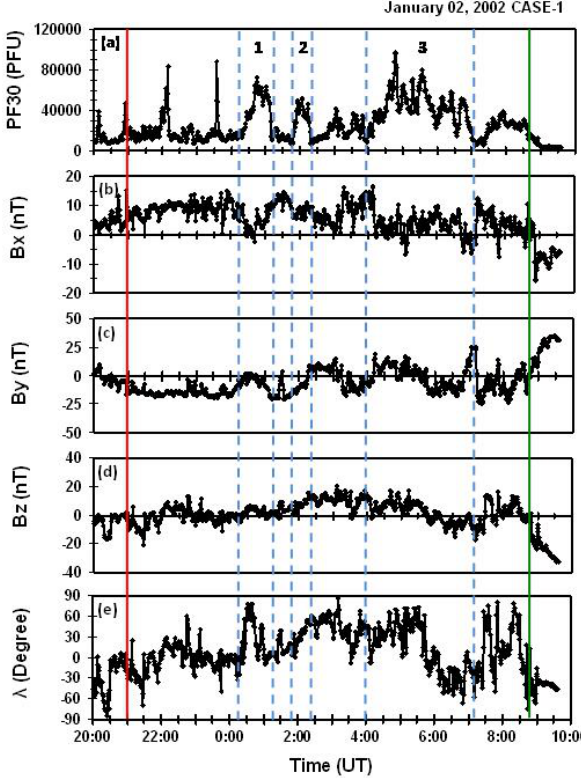
Fig. 7. Plot of particle flux (PF30) and magnetosheath magnetic field components, B x , B y , and B z and magnetic latitude ( B 2 ) from top to bottom versus time for 2 January 2002. The vertical lines mark the bow shock (red) and magnetopause